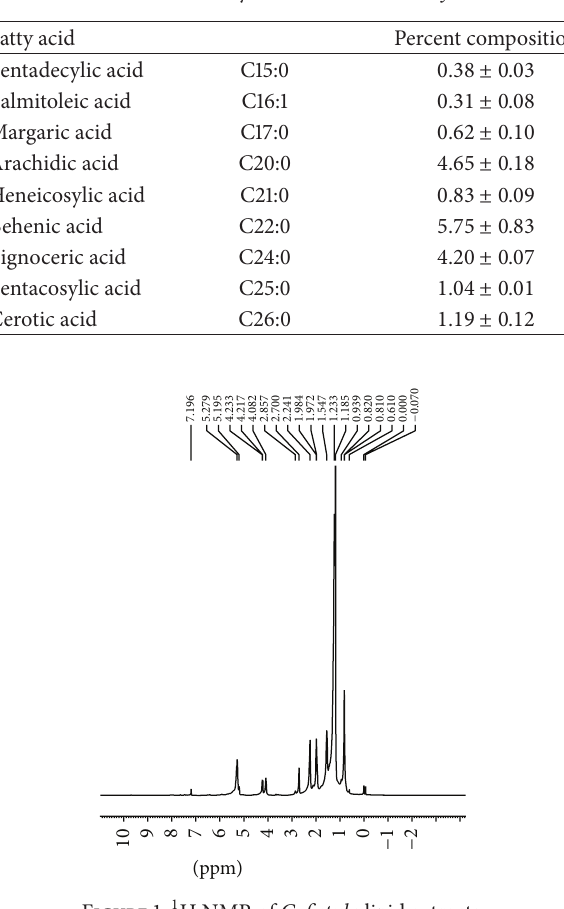
Table 3: Minor fatty acids identified in C. fistula .